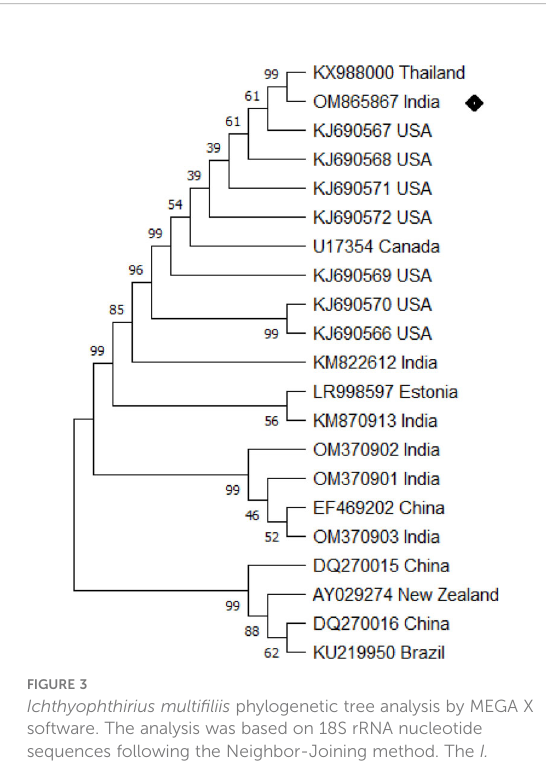
FIGURE 3 Ichthyophthirius multi fi liis phylogenetic tree analysis by MEGA X software. The analysis was based on 18S rRNA nucleotide sequences following the Neighbor-Joining method. The I. multi fi liis (OM865867) isolate identi fi ed in the study is indicated by a shaded rectangle.